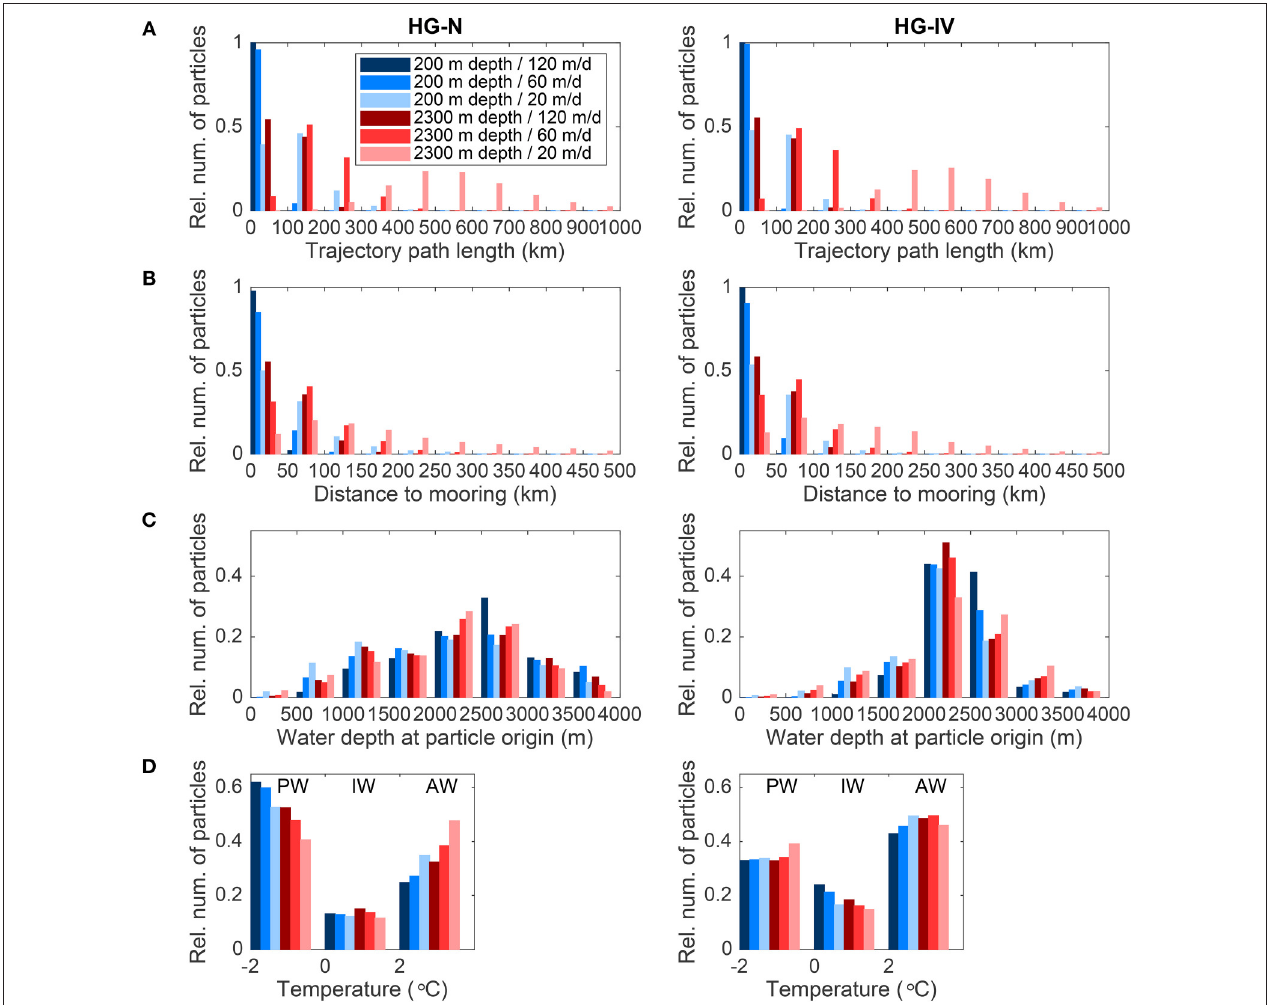
FIGURE 3 | Histograms of (A) travel path length in km, (B) distance in km between particle location at the surface and sediment traps, (C) water depth at the particle origin and (D) temperature at the particle surface position for sediment traps (left) HG-N and (right) HG-IV, different depths of particle release (200 and 2,300 m) and settling velocities (120, 60, and 20 m/d). Abbreviations PW, IW, and AW stand for water masses Polar Water (T < 0 ◦ C), Intermediate Water (0 ◦ C < T < 2 ◦ C) and Atlantic Water (T > 2 ◦ C),